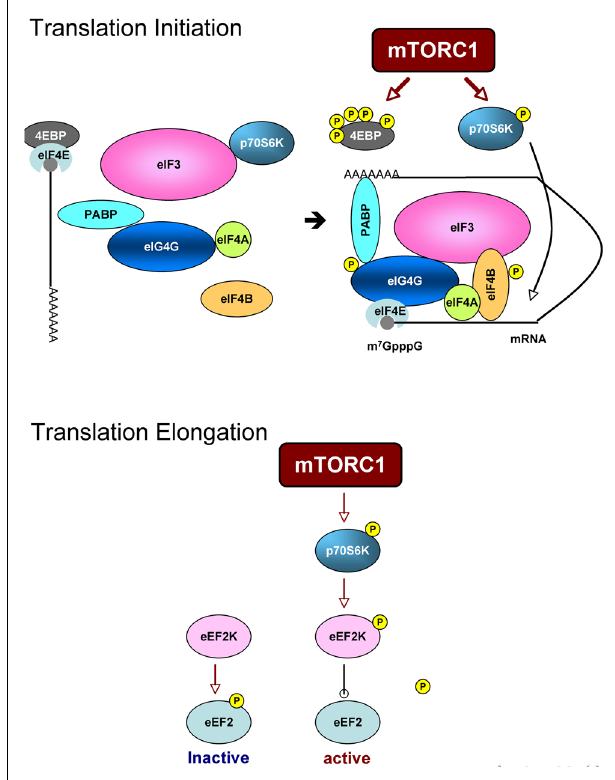
FIGURE 3 | Scheme of translation processes that are regulated by mTORC1. Upper panel: translation initiation. mTORC1 directly phosphorylates 4EBP and liberates eIF4E. eIF4E with mRNA then binds to eIF4G to form eIF4F complex. Phosphorylation of eIF4G and eIF4B is mTORC1-dependent. Assembly of eIF3 subunits and eIF4G is also thought to be mTORC1-dependent. Lower panel: translation elongation. p70S6K downstream of mTORC1 phosphorylates eEF2K and suppresses its activity to phosphorylate eEF2. Non-phosphorylated form of eEF2 is an active form thus enhances elongation